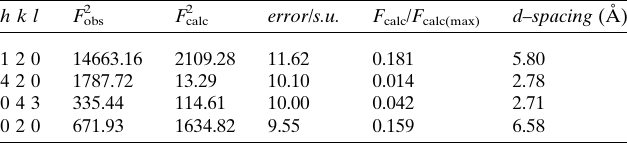
Table 2 List of the top four poorly fitting reflections for the model of the di- selenide shown in Fig. 3.